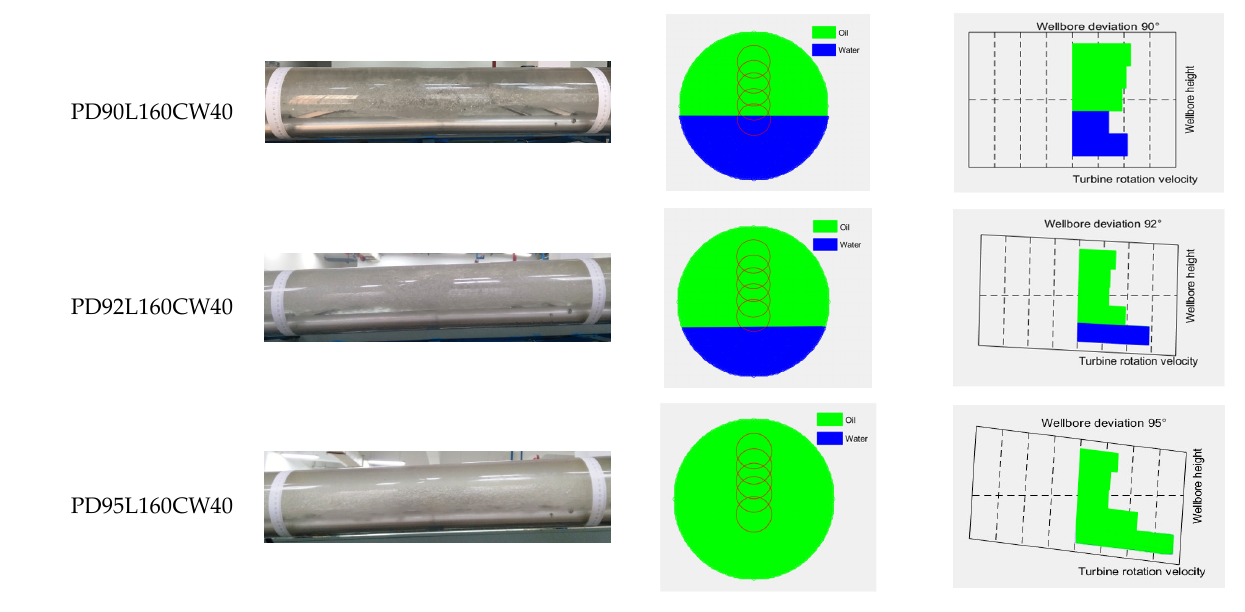
Figure 13. Comparison of flow imaging effects at the same flowrate, same water cut, and different wellbore deviation angles (L160CW40).